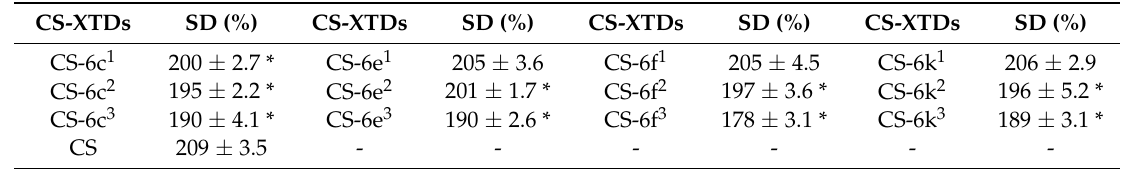
Figure 6. Swelling degree of CS and CS-XTDs (CS-6f; CS-6k) in SGF at different concentrations ( 1 = 3 mg/mL, 2 = 4 mg/mL, 3 = 5 mg/mL). Table 2. Swelling degree of CS and CS-XTD at thermodynamic equilibrium state.